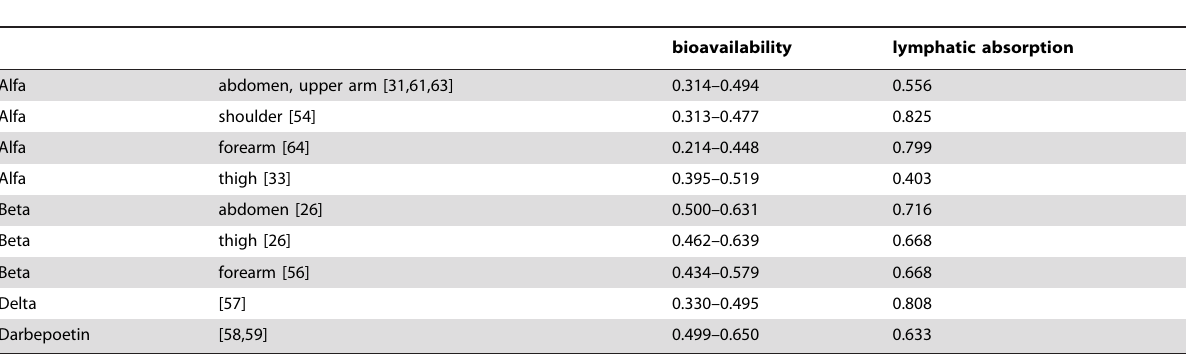
Table 2. Derived quantities based on parameters of the injection